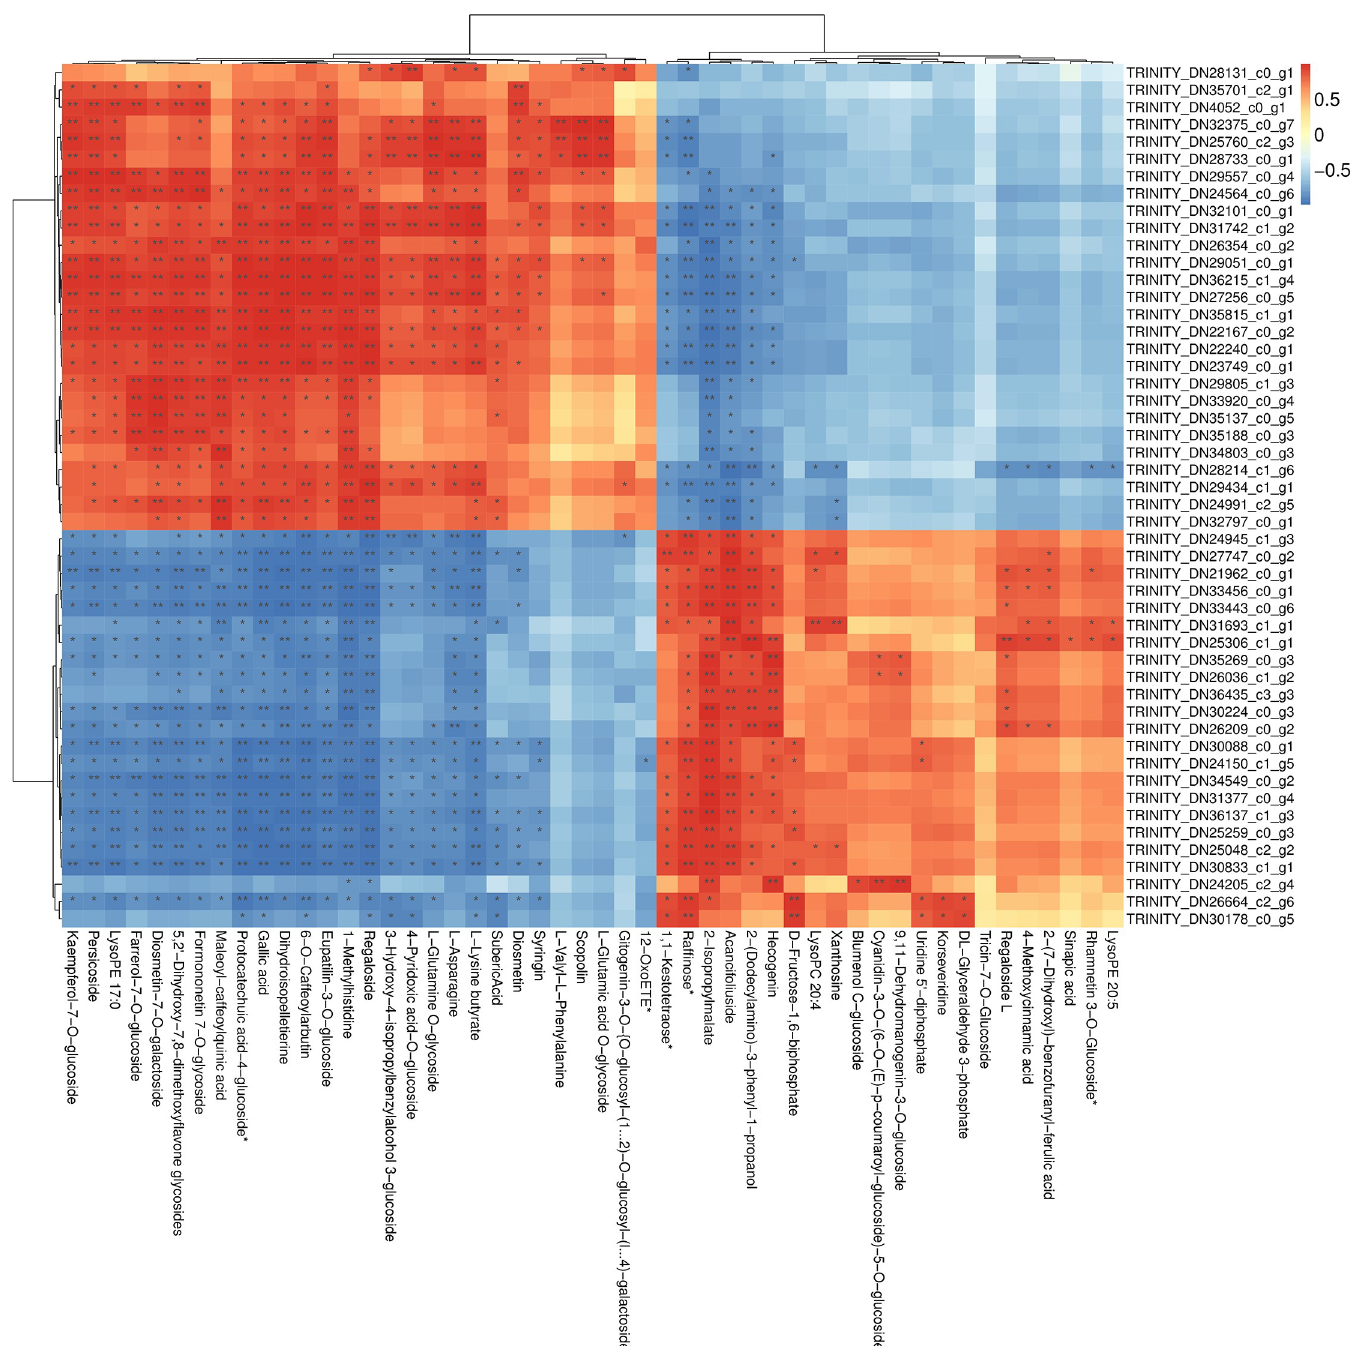
Fig 5. Correlation heat map analysis of transcriptome and